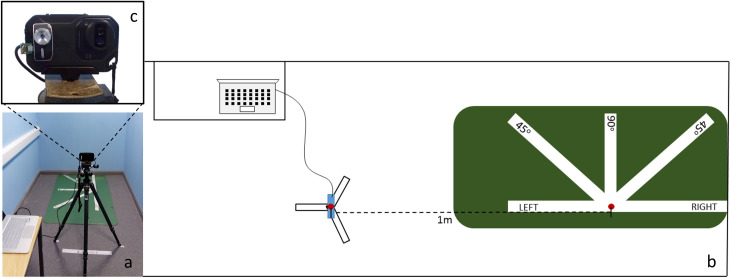
A controlled space free from any objects that could cause heat disturbance was used (a). The participant had to stand in the middle of the mat, with her left side to the cameras, which was placed 1 m away. Every minute the participant had to rotate by 45o, stepping on the relevant white line on the mat (b). The lenses from the two cameras were parallel at a distance of 7.5cm from each other (centres of lenses) (c).